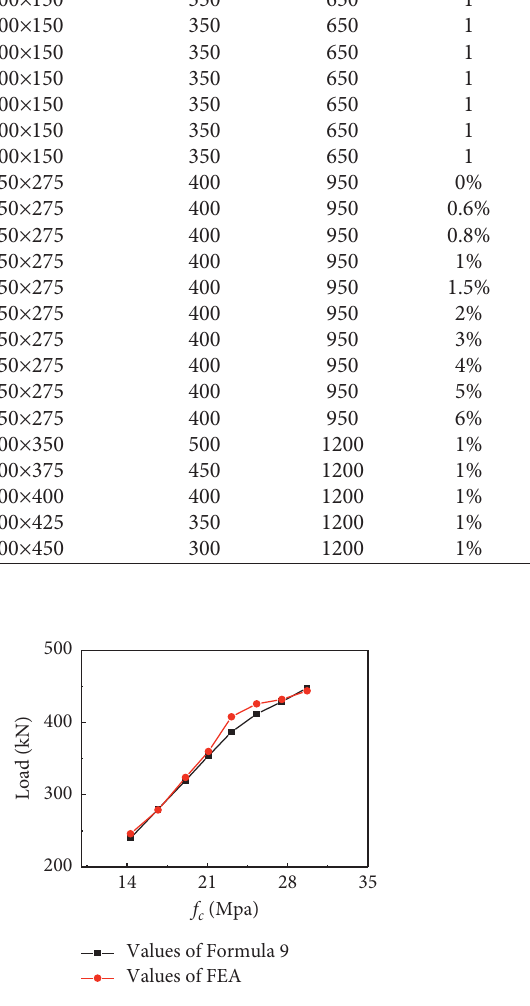
Figure 33: Values of formula (9) and FEA under changing of concrete strength (models FE6 to